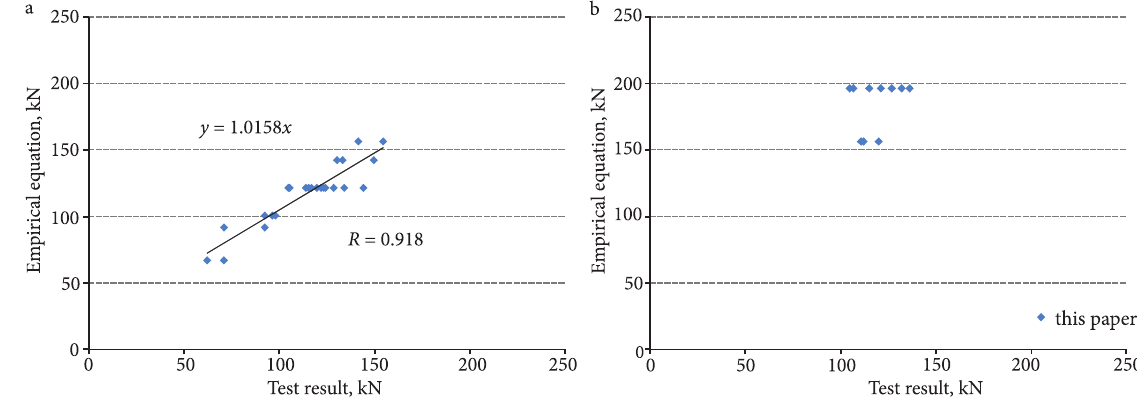
Fig. 7. Comparison of test results with previous empirical equation by Shim (2000): a – single arrangement of studs; b – group arrangement of studs